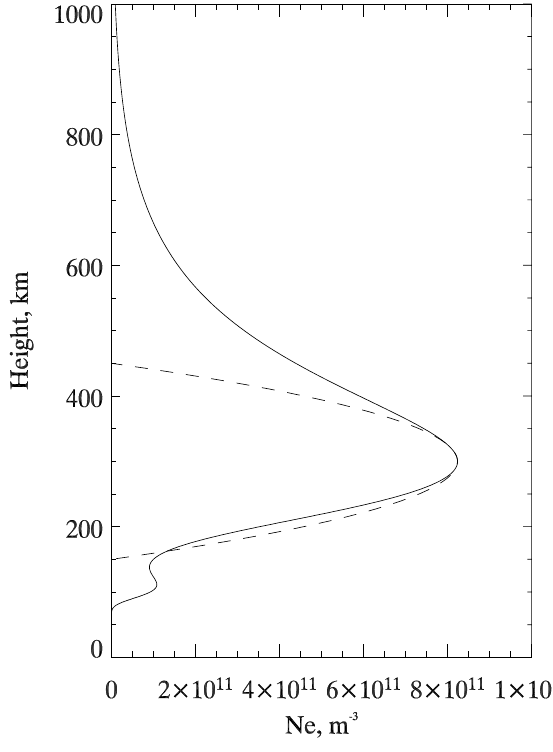
Fig. 5. Comparison of double-Chapman profile (solid line) used for more realistic simulations with the parabolic model from Fig. 1 (dashed